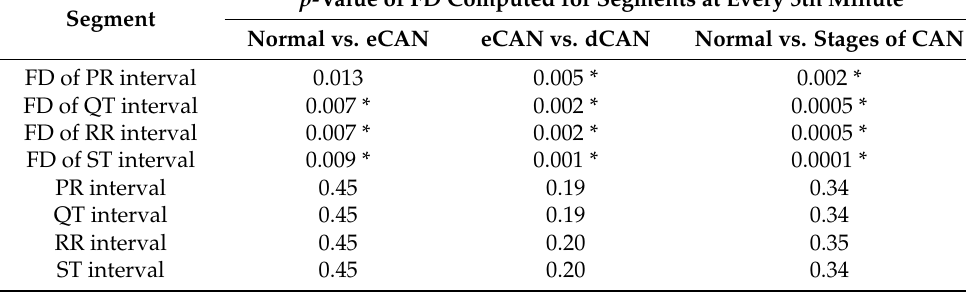
Table 4. p -value from Kruskal–Wallis test.